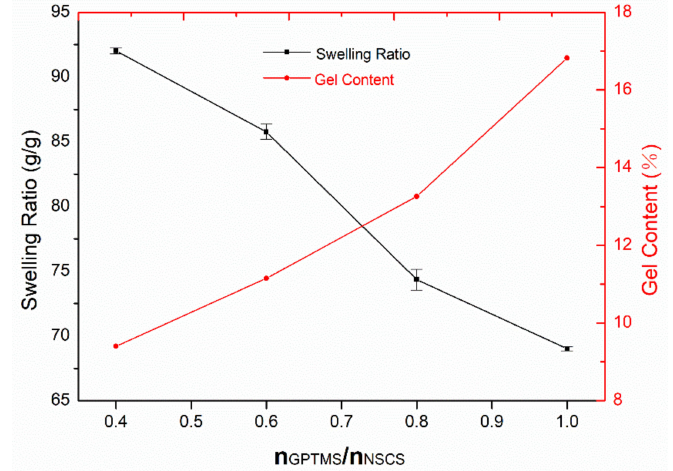
Figure 4. Swelling ratio (g / g) and gel content (G%) of GNCH.